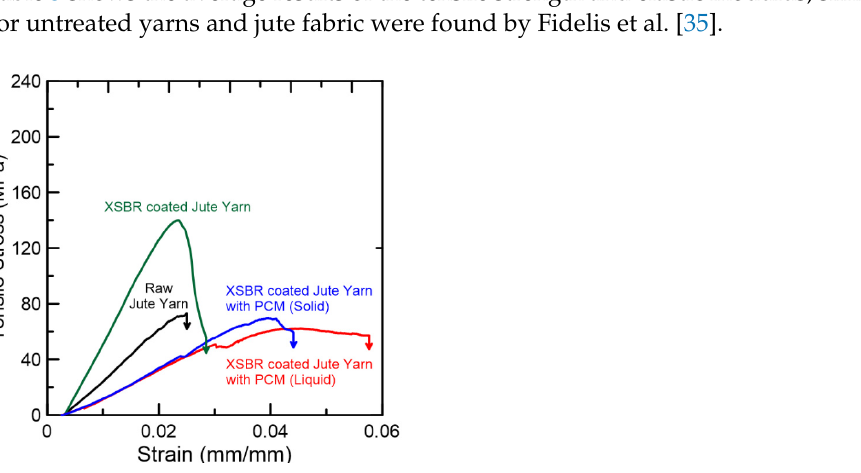
Figure 10. Typical curves from the tensile tests performed on jute yarns. Table 3. Tensile tests of studied jute yarns and fabric. Textile Component Tensile Strength (MPa) Elastic Modulus